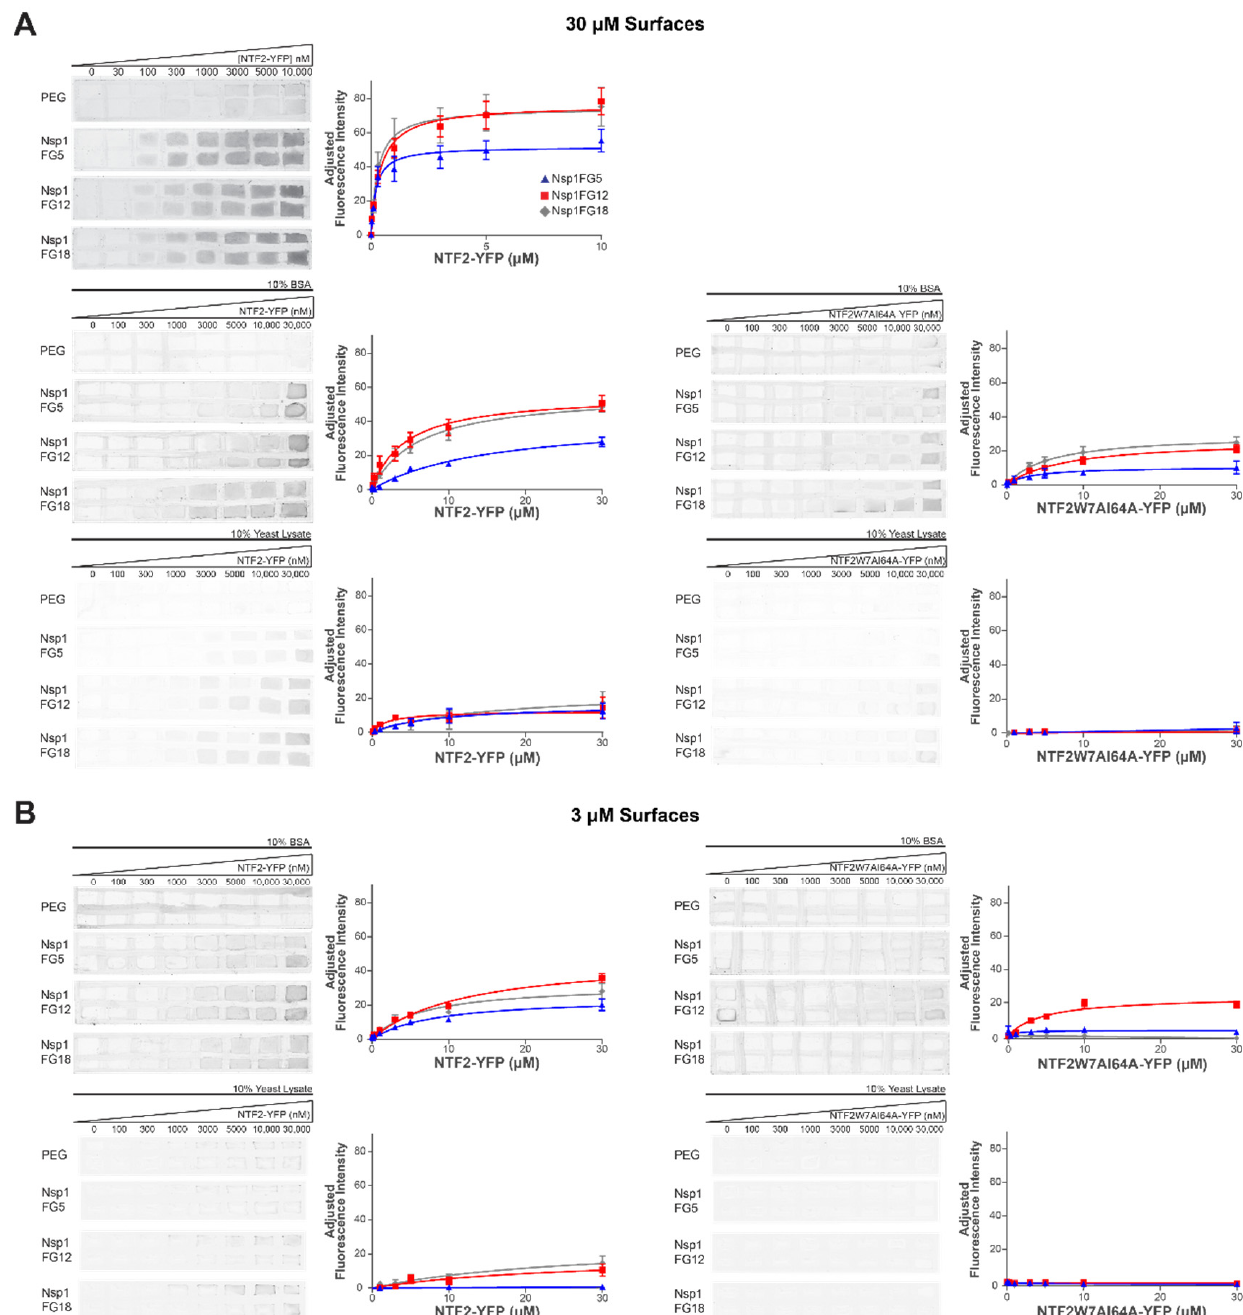
Figure 2. NTF2-YFP and NTF2W7AI64A-YFP binding on Nsp1FG and PEG surfaces. ( A ) Left: Representative fluorescent images and binding curves of NTF2-YFP; incubating [Nsp1FG variants] = 30 μ M. Right: representative fluorescent images and binding curves of NTF2W7AI64A-YFP; incubating [Nsp1FG variants] = 30 μ M. Error bars represent SEM. n = 8 ROIs, 4 independent measurements for TBT buffer and 10% BSA in TBT buffer; n = 4 ROIs, 2 independent measurements for 10% YL in TBT buffer. ( B ) Left: Representative fluorescent images and binding curves of NTF2-YFP; incubating [Nsp1FG variants] = 3 µ M. Right: representative fluorescent images and binding curves of NTF2W7AI64A-YFP; incubating [Nsp1FG variants] = 3 µ M. Error bars represent SEM. In each case, n = 6 ROIs, 3 independent measurements.